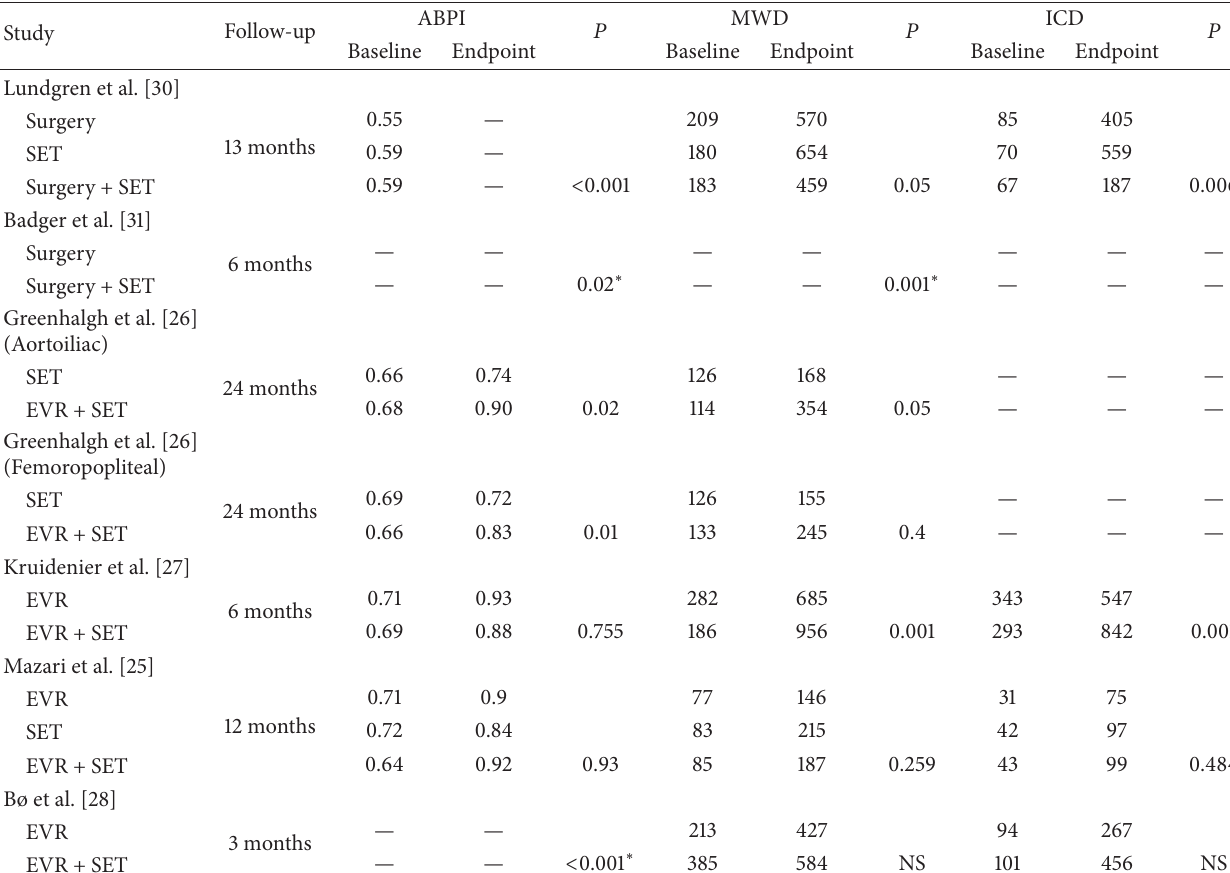
Table 4: Supervised exercise plus invasive measures (open surgery or EVR) versus